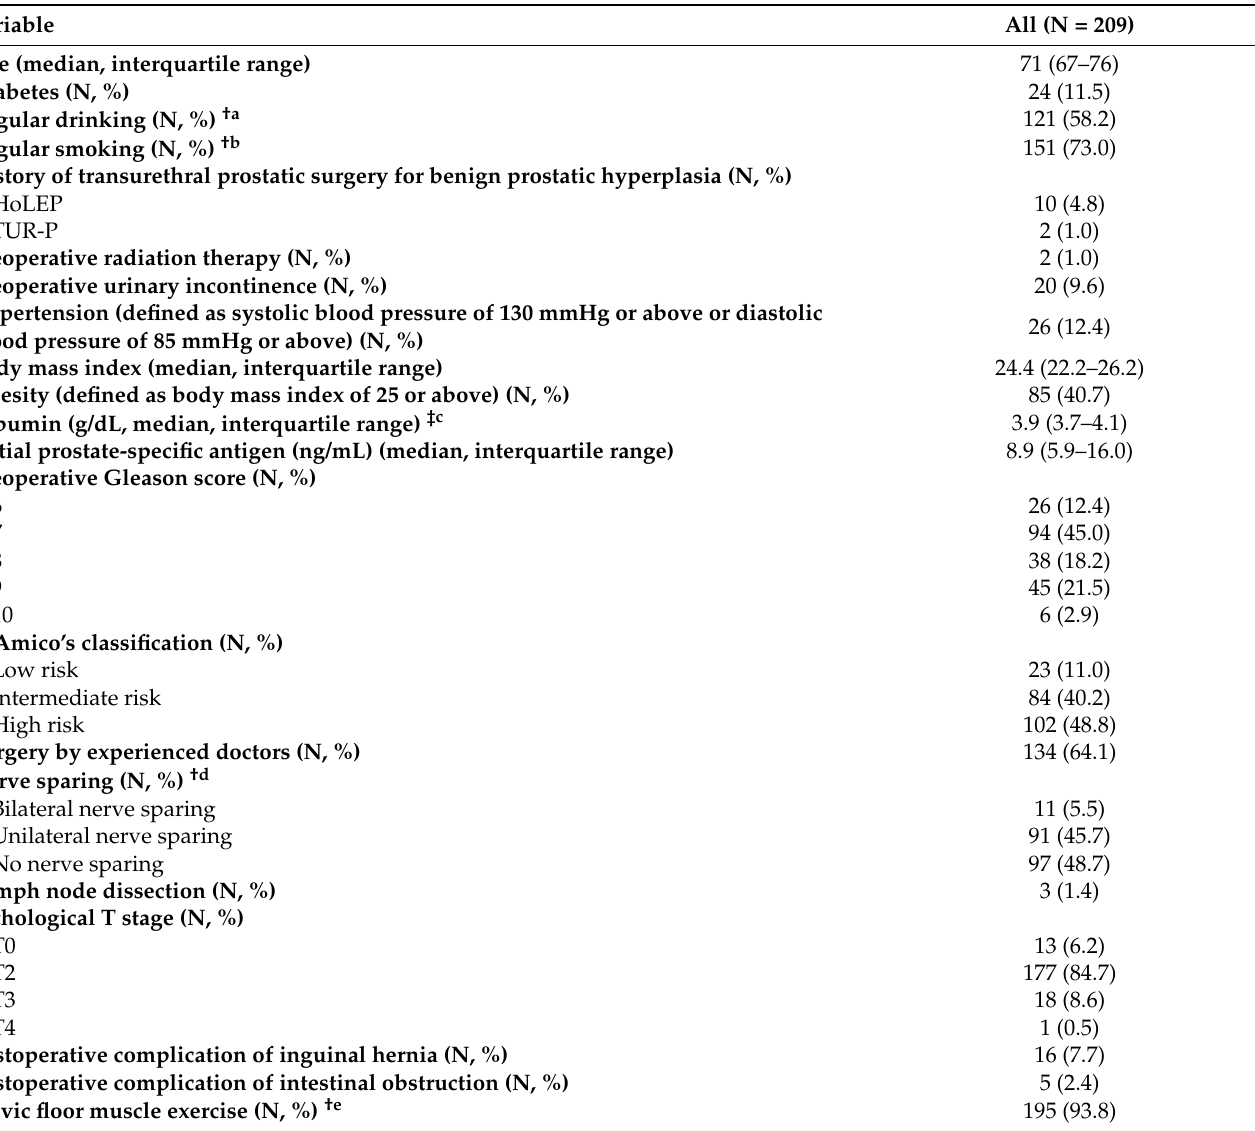
Table 1. Patients’